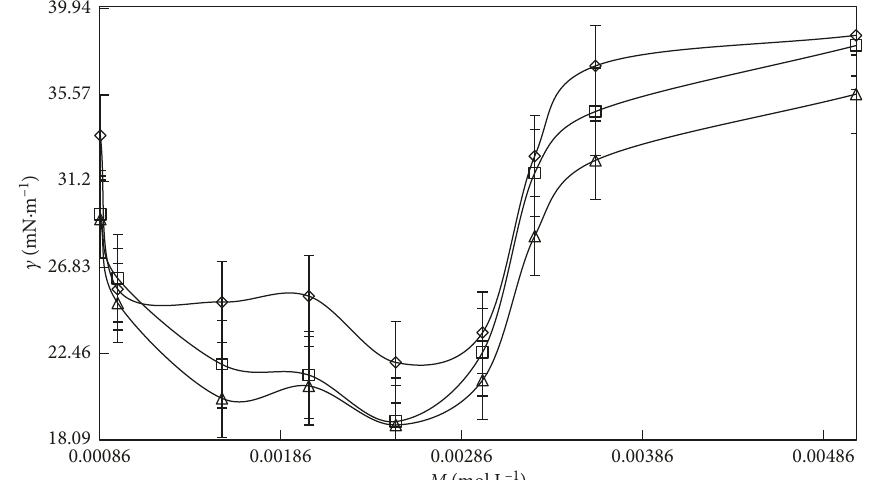
Figure 11: The c value of the DTAB-rich surfactant at the three different temperatures T � 293.15 ( ◊ ), 298.15 ( □ ), and 303.15K ( △ ),